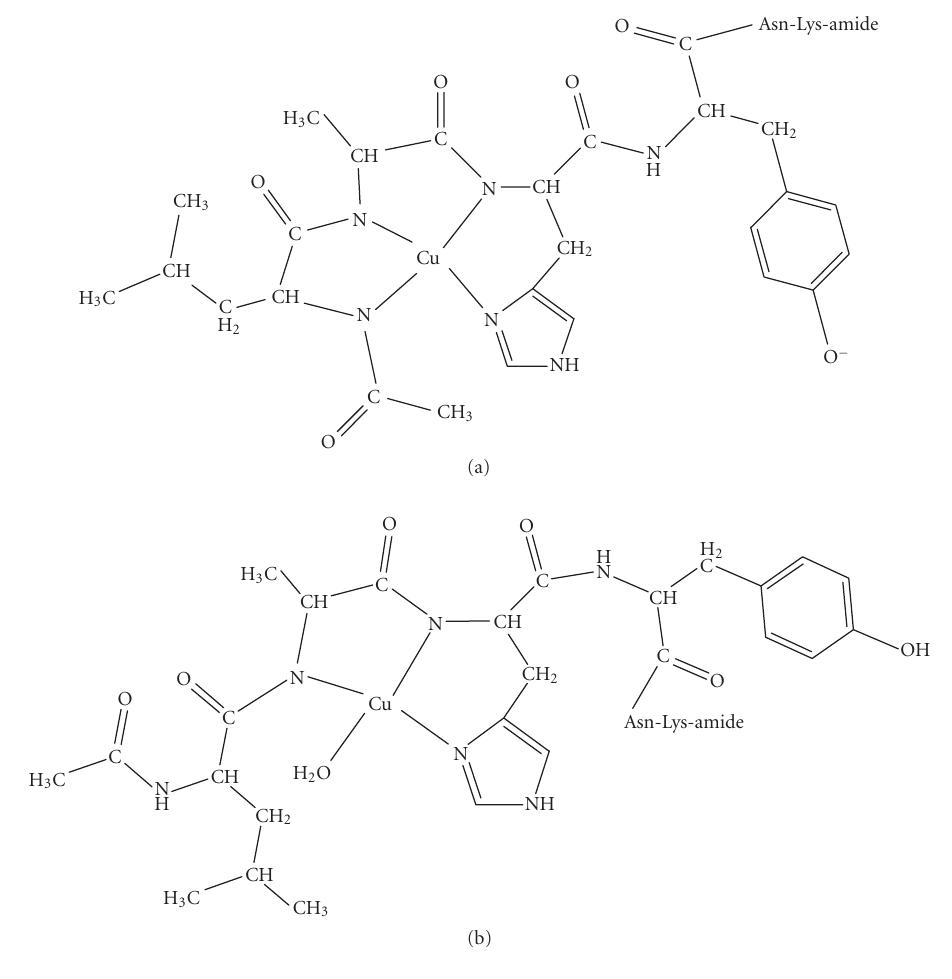
Scheme 2: Possible structures of (a) CuH − 2 L (b) CuL.